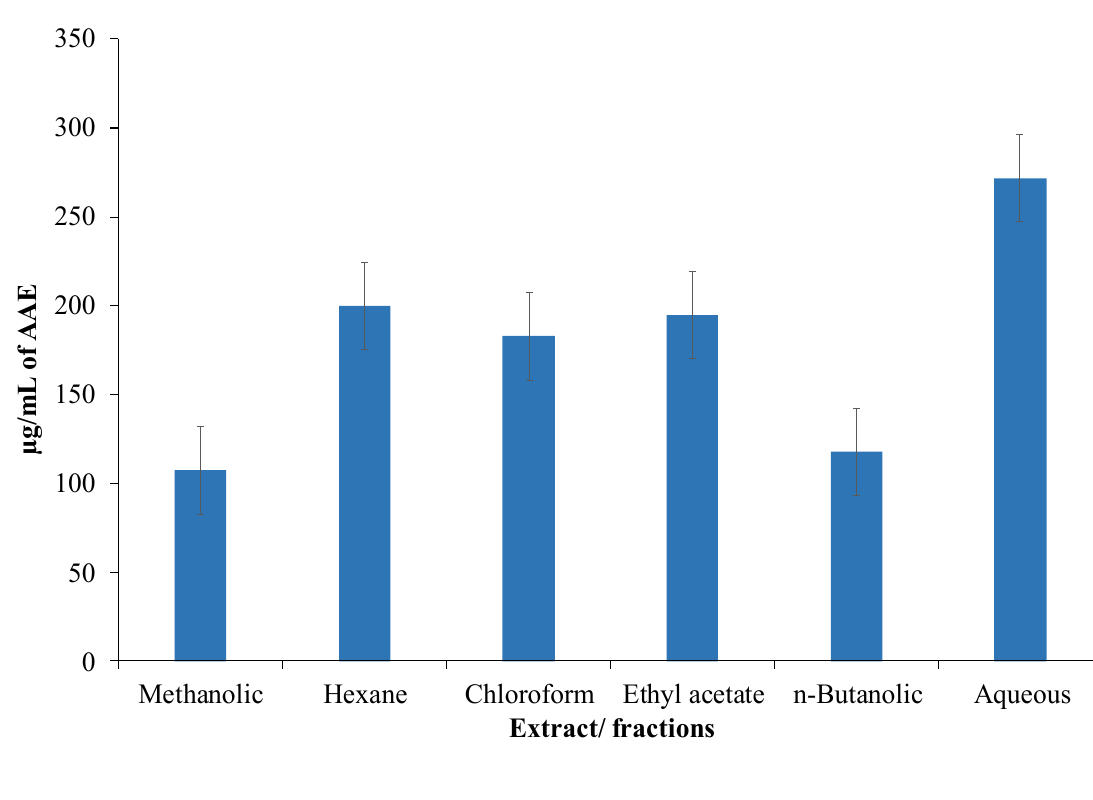
Figure 4. Antioxidant capacity of methanolic extract of Carissa opaca roots and its fractions in various solvents as per phosphomolybdate assay in units of μg/mL of ascorbic acid equivalents